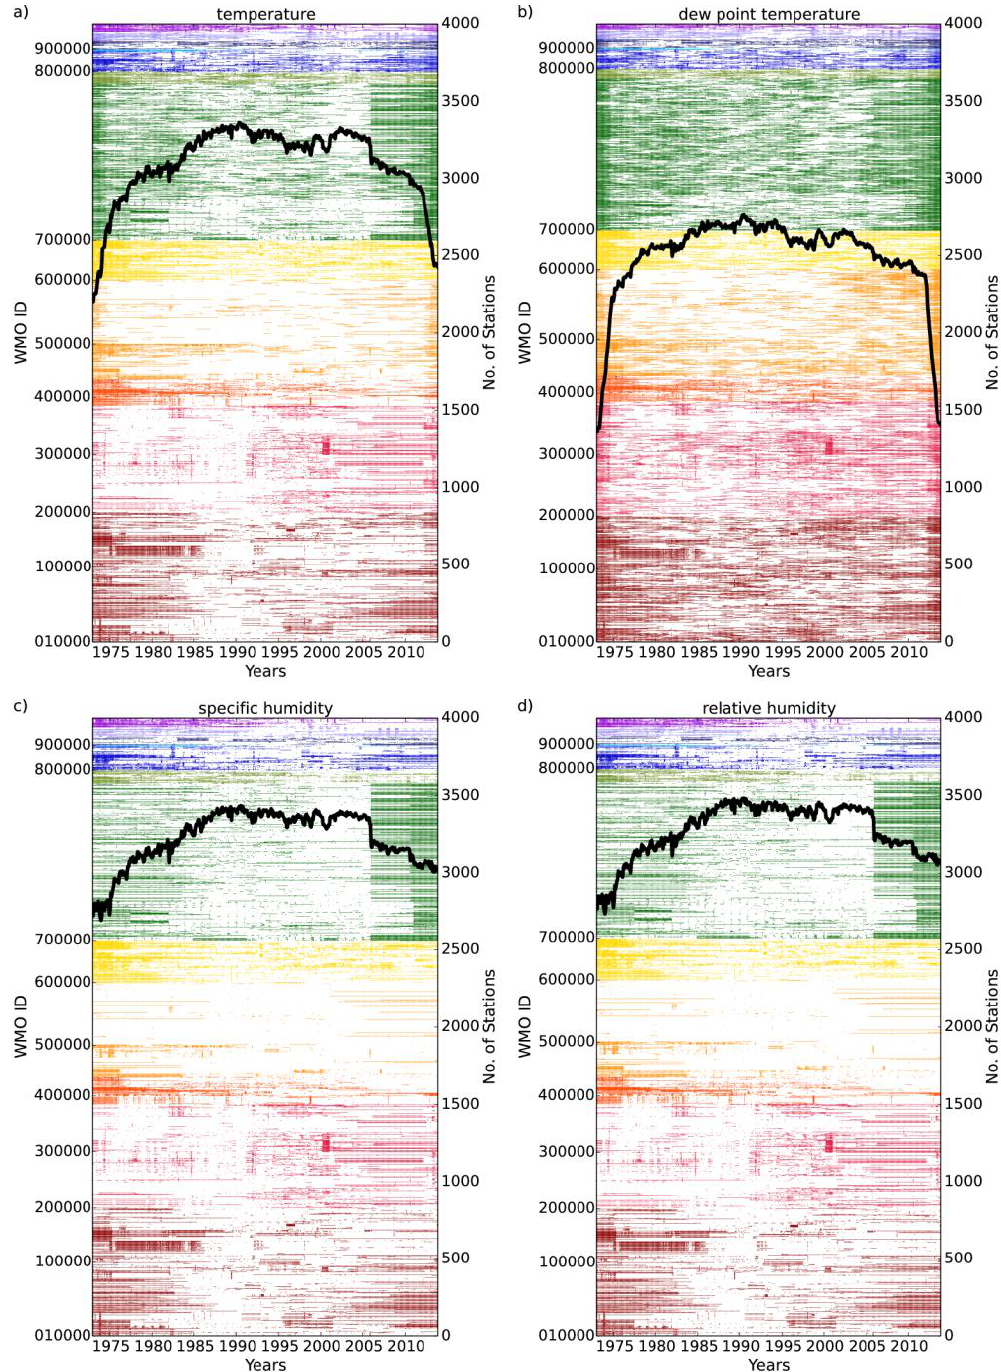
Figure 3. Station temporal coverage. Colours show missing station months by WMO ID (left y-axis) and the solid black line shows total station count (right y-axis). WMO IDs/colours are bounded as follows: Europe: 0-199999 (dark red), Russia/Eastern Europe: 200000-379999 (crimson), Central Asia/Middle East/India/Pakistan: 380000-439999 (dark orange), South East Asia/East Asia/China: 440000-599850 (orange), Africa: 600000-689999 (gold), USA/Canada: 690000-749999 (dark green), Central America: 760000-799999 (olive green), South America: 800000-879999 (royal blue), Antarctica: 880000-899999 (sky blue), Pacific Islands (Inc. Hawaii): 911000-919999 (navy), Papua New Guinea/Australia/New Zealand: 930000-949999 (lilac), Indonesia/Philippines/Borneo: 960000-999999 (purple). a) temperature, b) dew point temperature, c) specific humidity and d) relative humidity. See Figure SM2 for other variables.